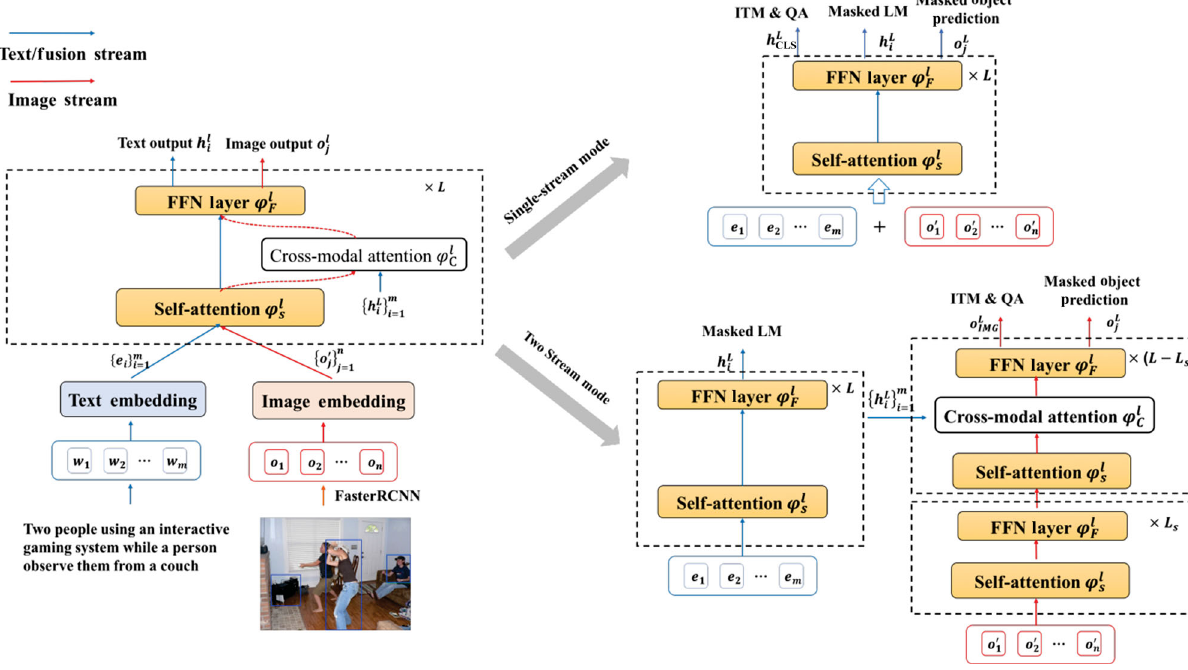
Fig. 25 Overview of SemVLP. Reproduced with permission from Ref. [42], c (cid:2) The Author(s)